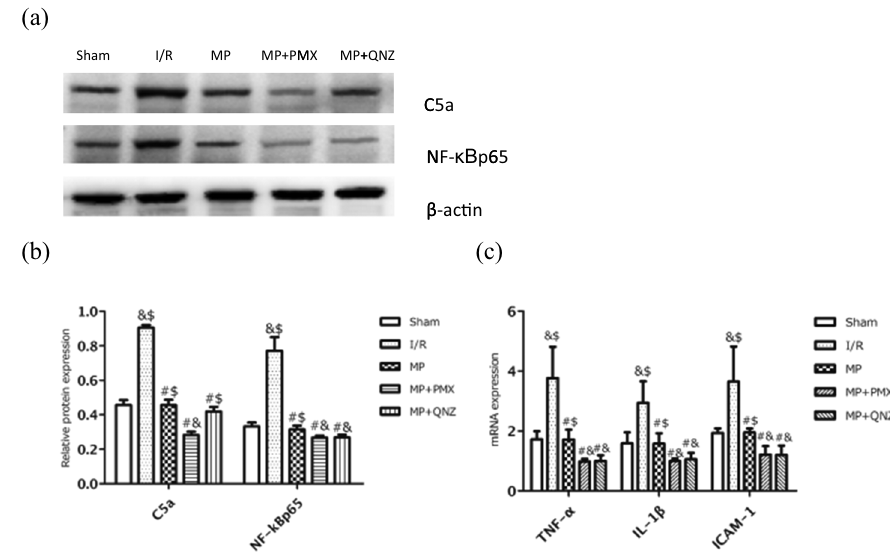
Figure 5: E ff ects of PMX and QNZ on C5a, NF - κ Bp65, TNF - α , IL - 1 β , and ICAM - 1 expression. ( a ) Representative Western blots showing the expression of C5a and NF - κ Bp65. ( b ) Relative expression of C5a and NF - κ Bp65 proteins. ( c ) The mRNA levels of TNF - α , IL - 1 β , and ICAM - 1 were measured using qPCR in di ff erent groups. Values are presented as mean ± standard deviation. # P < 0.05 vs I/R group; & P < 0.05 vs MP group; $ P < 0.05 vs MP + P MX group; n = 5 for each group. I/R: ischemia/reperfusion; MP: morphine postconditioning; GA: geldanamycin; GSK: GSK - 690693; PMX: PMX 205; QNZ: